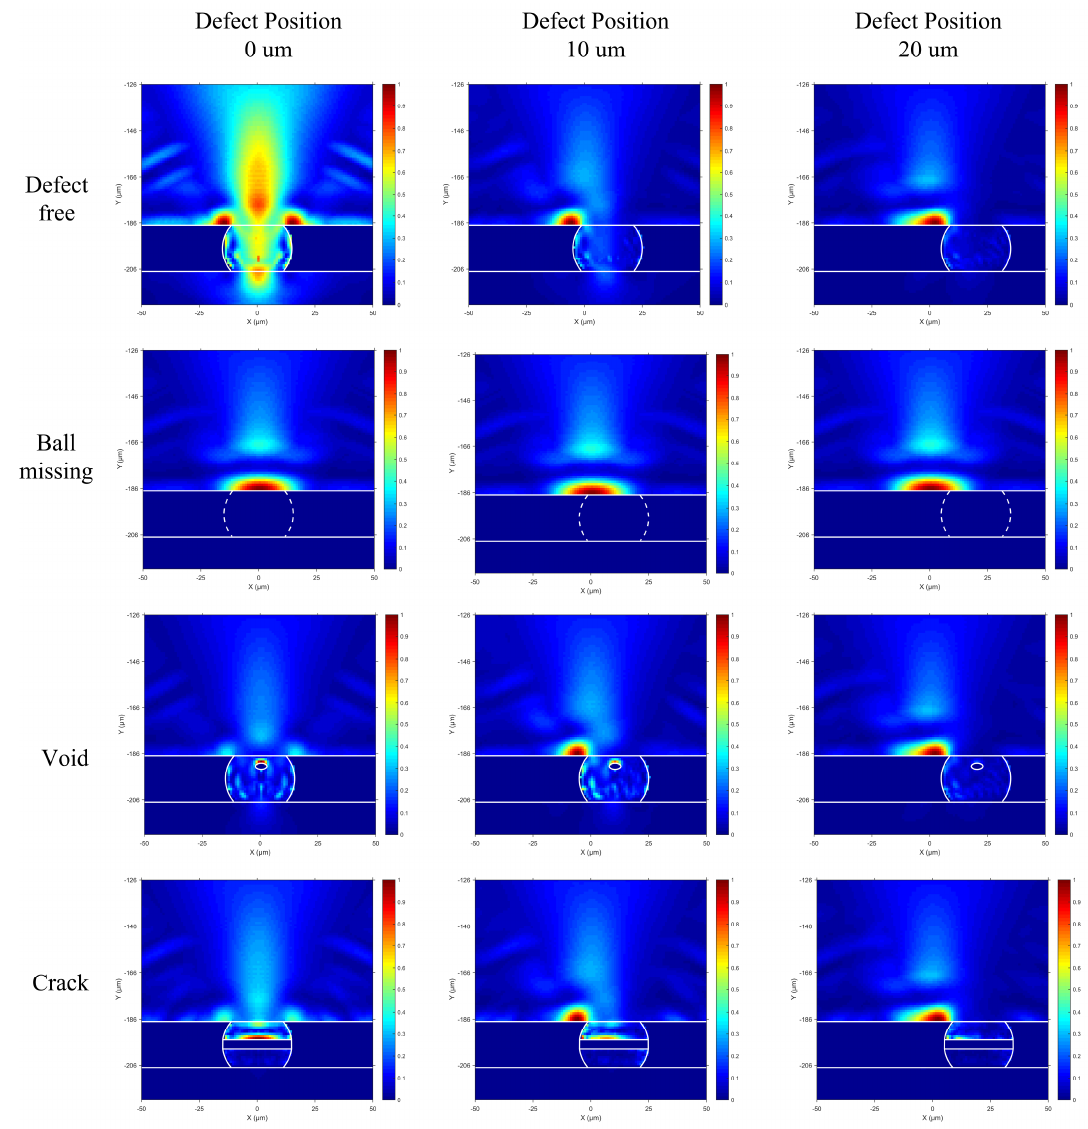
Figure 7. Appl. Sci. 2020 , 10 , x FOR PEER REVIEW